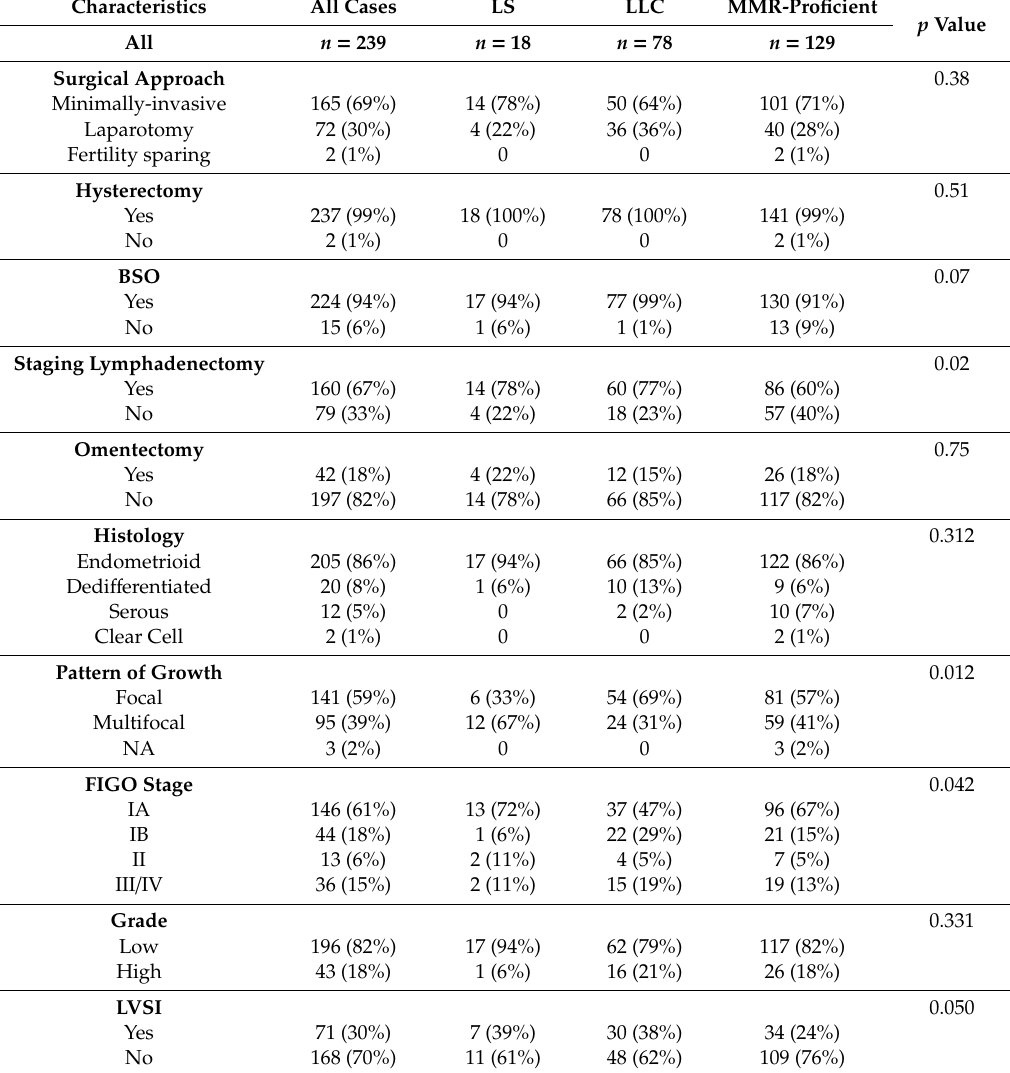
Figure 3. Kaplan-Meier curve for Progression Free Survival (PFS) of mismatch repair-proficient (MMR-proficient) patients according to the parity. Table 3. Surgical, pathological, adjuvant therapies and follow up data in the three groups study.